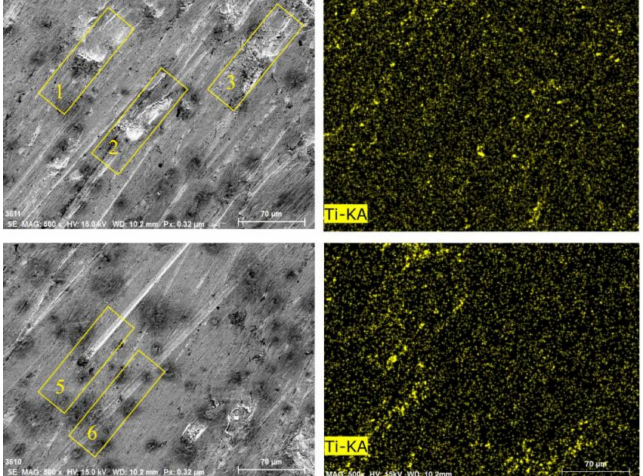
Figure 18. Surface morphologies and Ti surface distribution of ZM4-13 after worn under coal gangue percentage of 50% and simulated mine water of